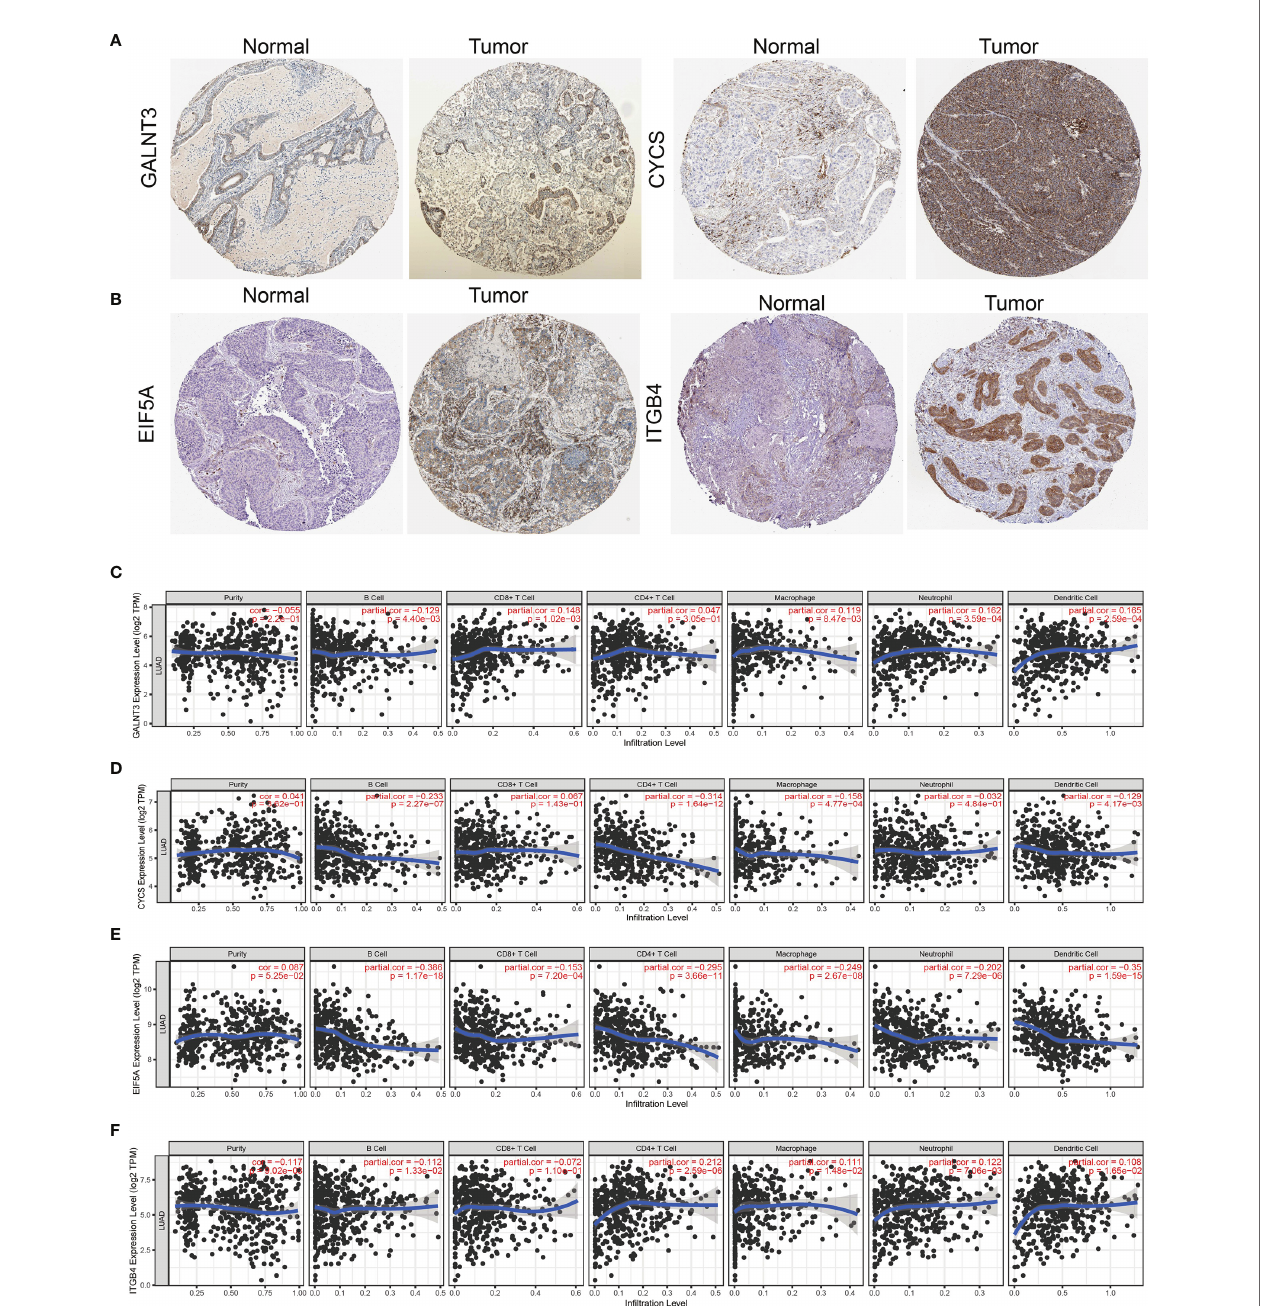
FIGURE 9 | Analysis of the GALNT3, CYCS, EIF5A, and ITGB4 expression and the immune level of correlation. (A, B) The protein expression of GALNT3, CYCS, EIF5A, and ITGB4 in LUAD examined by HPA database. (C – F) The expression of GALNT3, CYCS, EIF5A, and ITGB4 in LUAD was correlated with tumor purity, B cells, CD4 + T cells, CD8 + T cells, macrophages, neutrophils, and dendritic